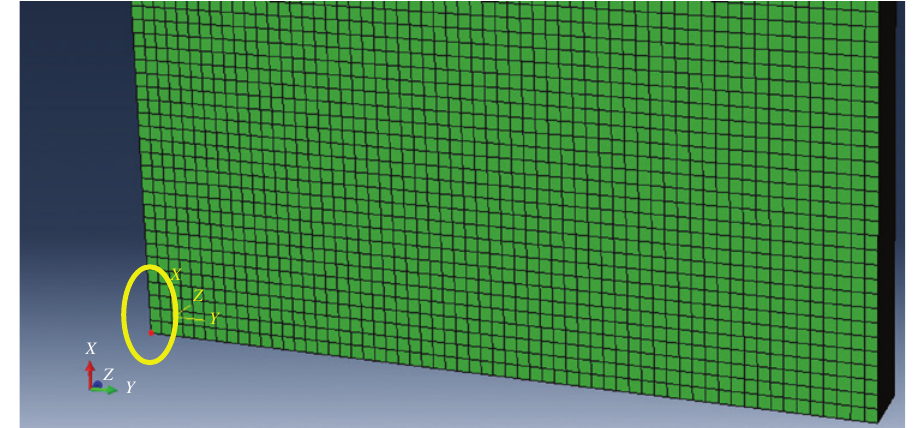
Figure 14: Nodal point of a